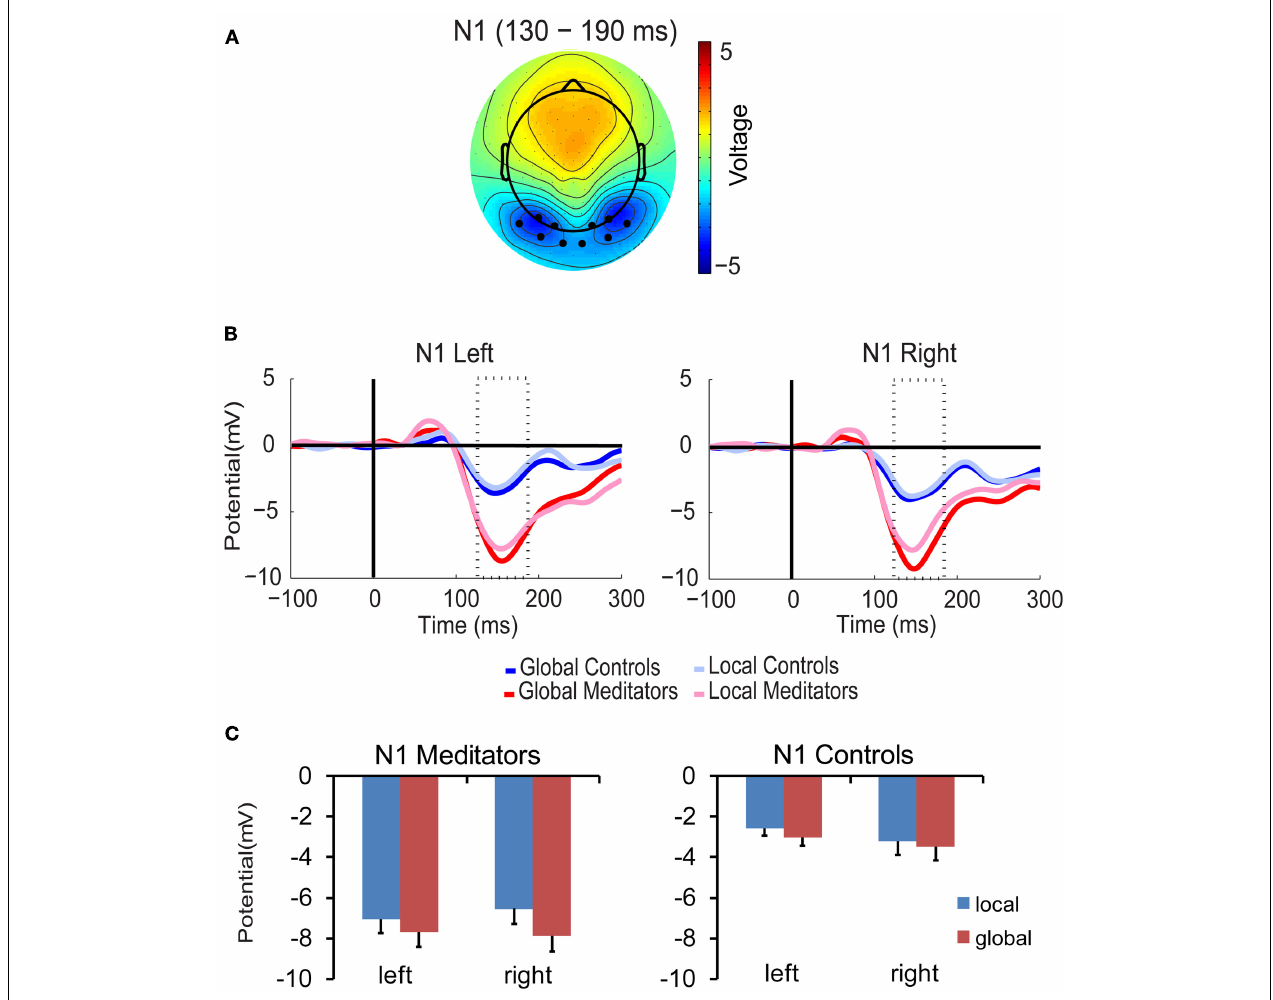
FIGURE 4 | N1 component. (A) Scalp topographies of the N1 component over conditions, groups, and the N1 time period (130–190ms). Black dots represent the electrodes included in the analysis. (B) N1 waveforms. (C) Bar plots. All conventions as in Figure 3 .